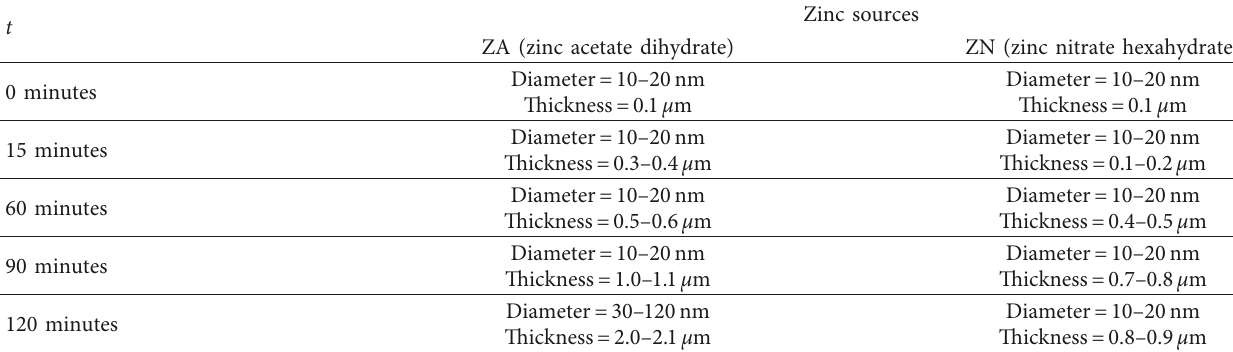
Table 1: Sizes of ZnO NR diameter and thickness grown from ZA and ZN sources at various growth times t